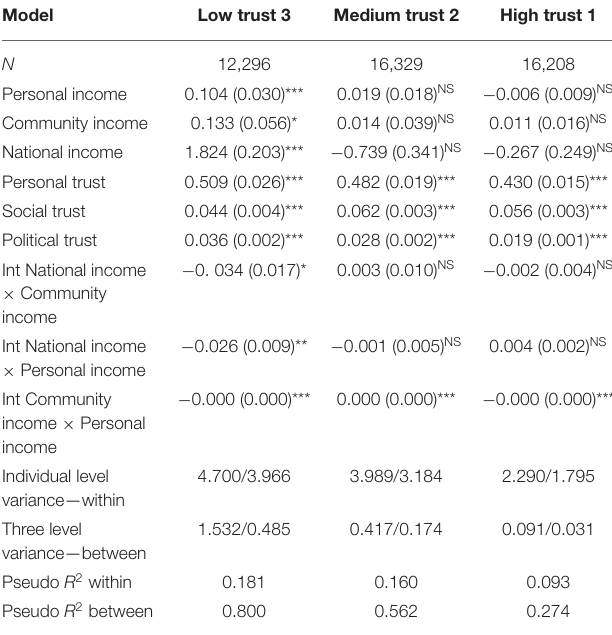
TABLE 4 | Results three models [fixed effects (Beta (SE)sig) and pseudo R 2 (explained variance)] for three models (based on country trust groups) of multilevel analysis of personal life satisfaction (at individual level) against personal, social and national income and against personal, social and political trust (model 4 in Table 3